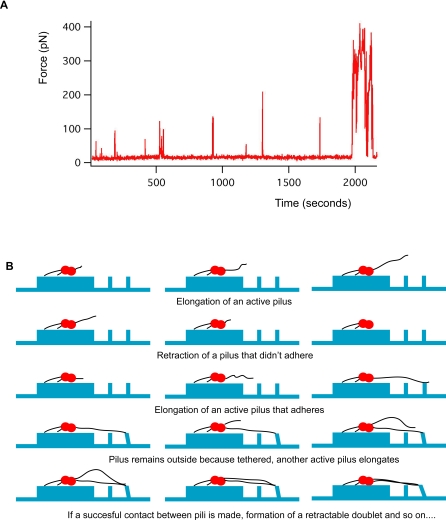
Model for Tfp Bundling and Retraction(A) Progressive rise of force applied by a bacterium on one pillar over time (more than 30 min total time).(B) Cartoon showing the successive association (bundling) of Tfp filaments with each other and their retraction. Timeline begins with top left panel and is read from left to right, top to bottom.